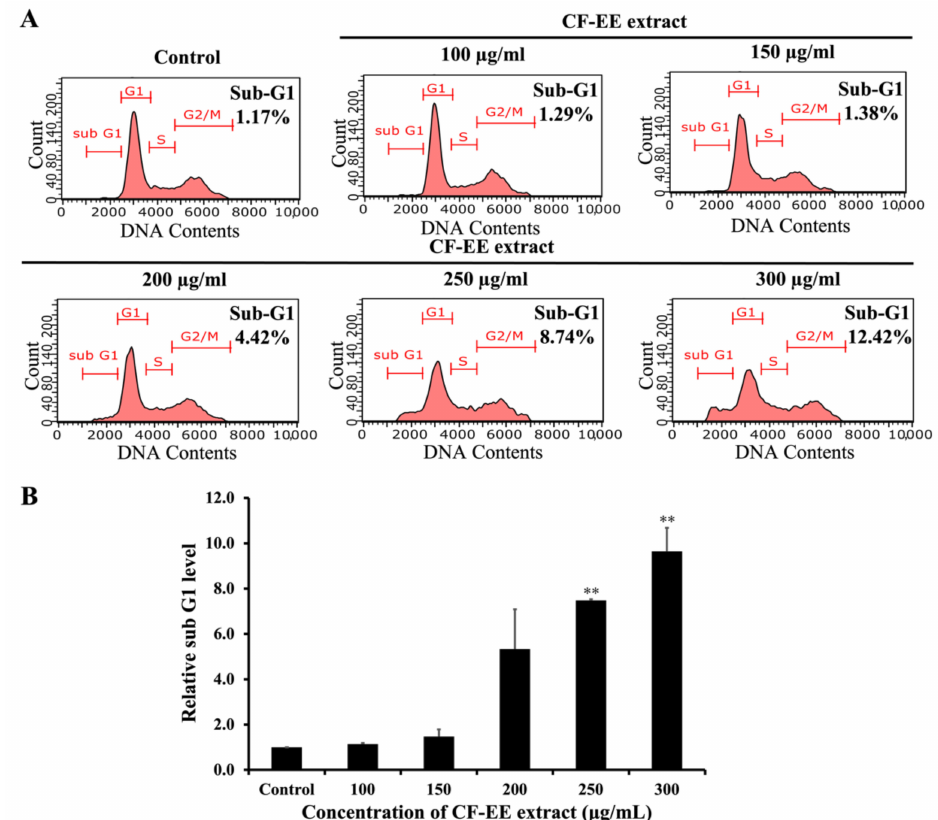
Figure 4. Effect of CF-EE extract on the accumulation of sub-G1 population in HeLa cells. The cells were treated with 100, 150, 200, 250, and 300 µ g/mL of CF-EE extract for 12 h. The cells were fixed and stained with Guava Cell Cycle ® reagent, then analyzed by a flow cytometer. ( A ) DNA content profiles. ( B ) Relative sub-G1 level of CF-EE extract-treated cells. The values are represented as the mean ± SD. ** p < 0.01 compared to the